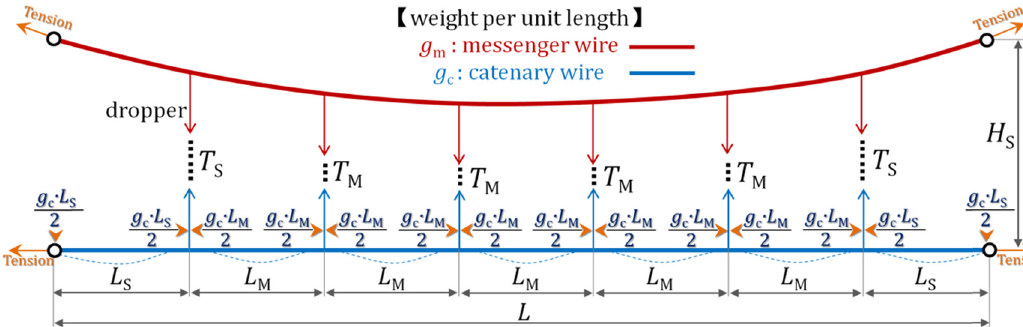
Figure 5: Equilibrium state calculation by separate model